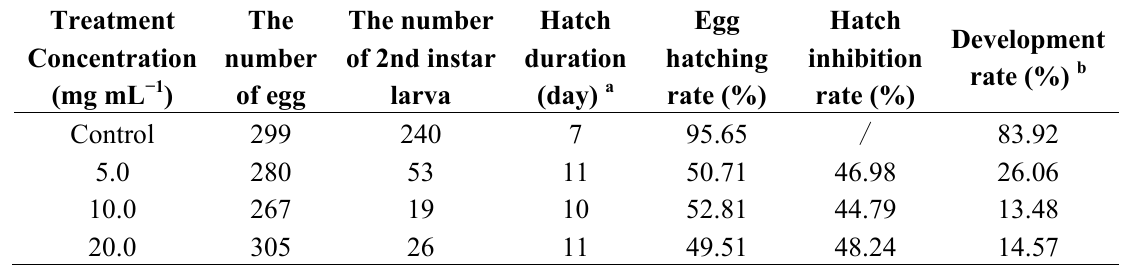
Table 2. Effect of fraxinellone on egg hatching rates and hatched-larvae development of M. separate .